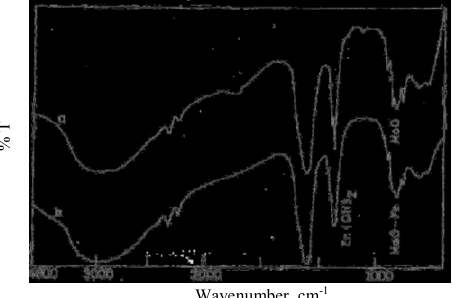
Figure 2. FTIR Spectra (KBr), (a)Pure sodium molybdate (SM), Film formed on carbon steel after immersion in solution containing 120 ppm of Cl - + 50 ppm of SM + 50 ppm of Zn 2+ .